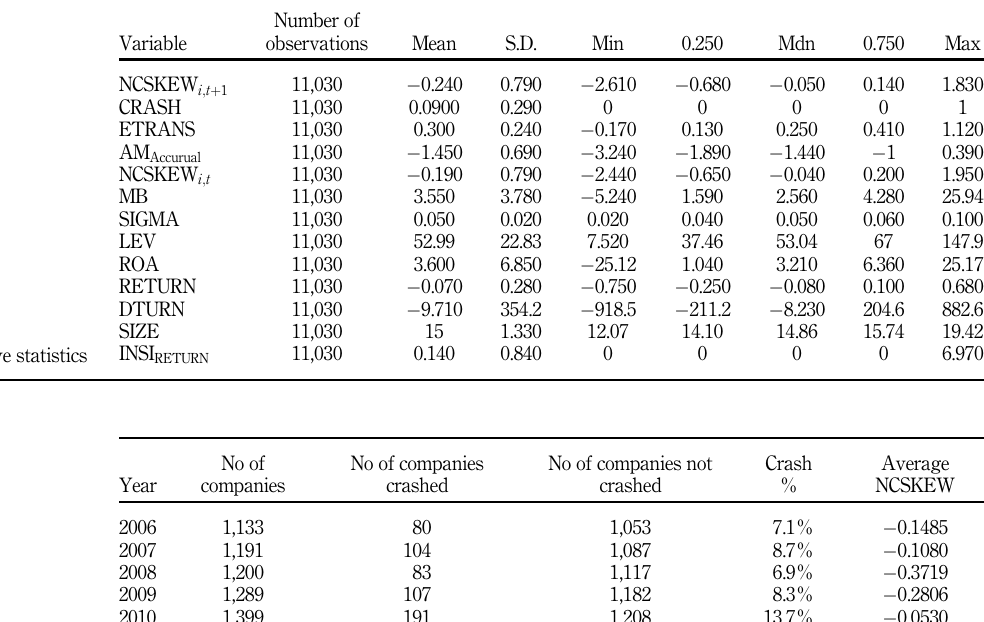
Table 2. Summary of crashed